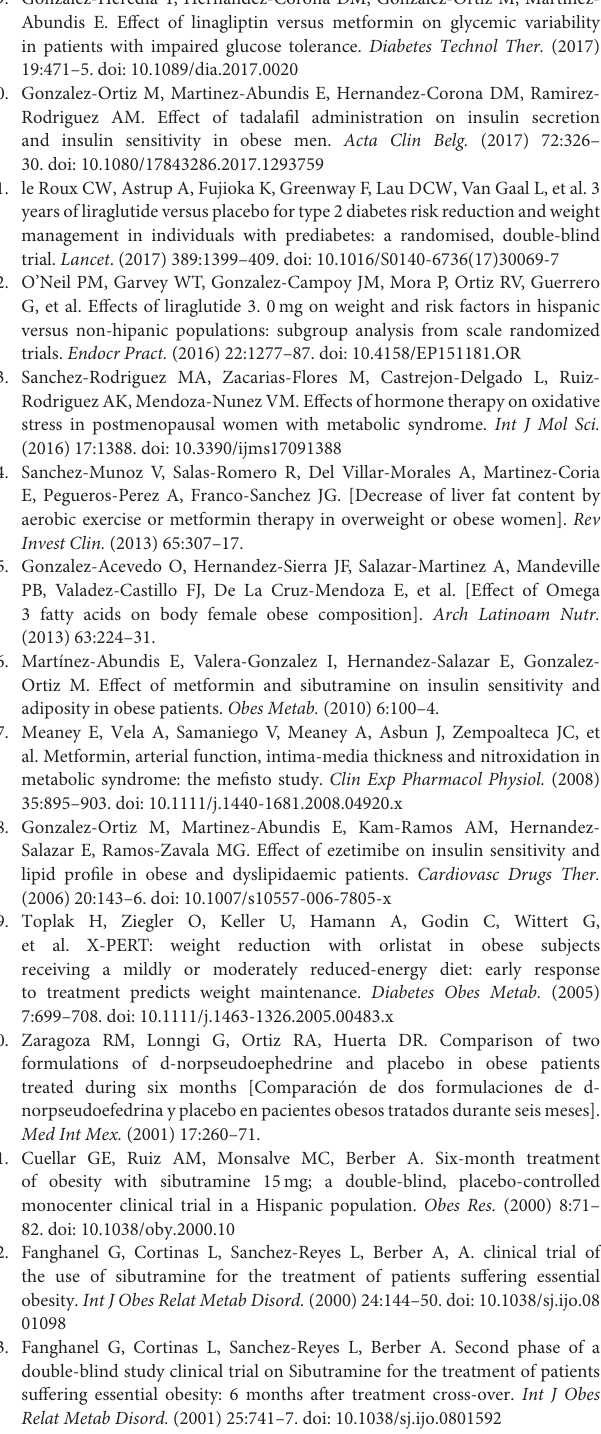
Supplementary Table 2 | Network meta-analysis results matrix. Estimates of the effect of treatments (standardized mean differences with 95% CI) relative to metformin in patients with diabetes. The Form1 and Form2 are described in the text, they are not approved by